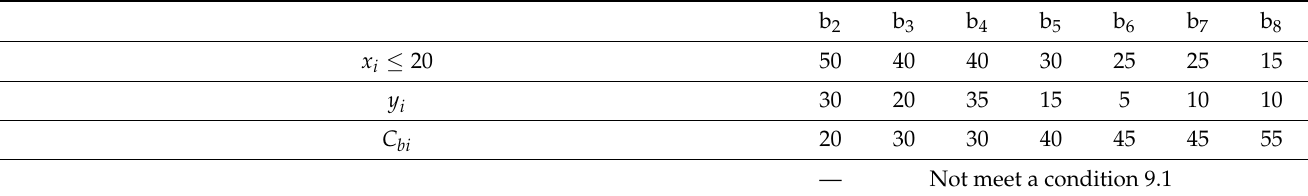
Table 10. Branch and bound for b i at X avi < 20.